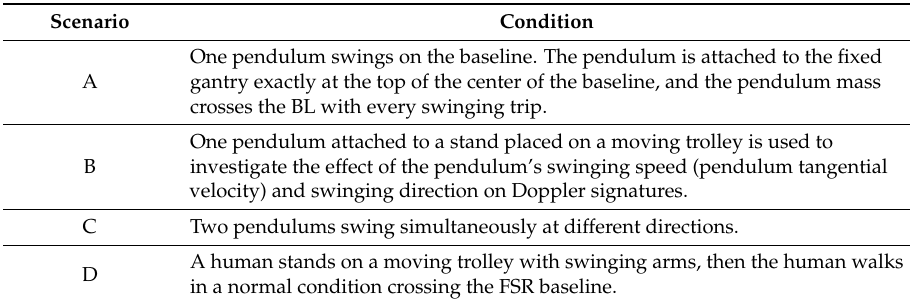
Table 1. Scenarios tested during the micro-Doppler experiment.